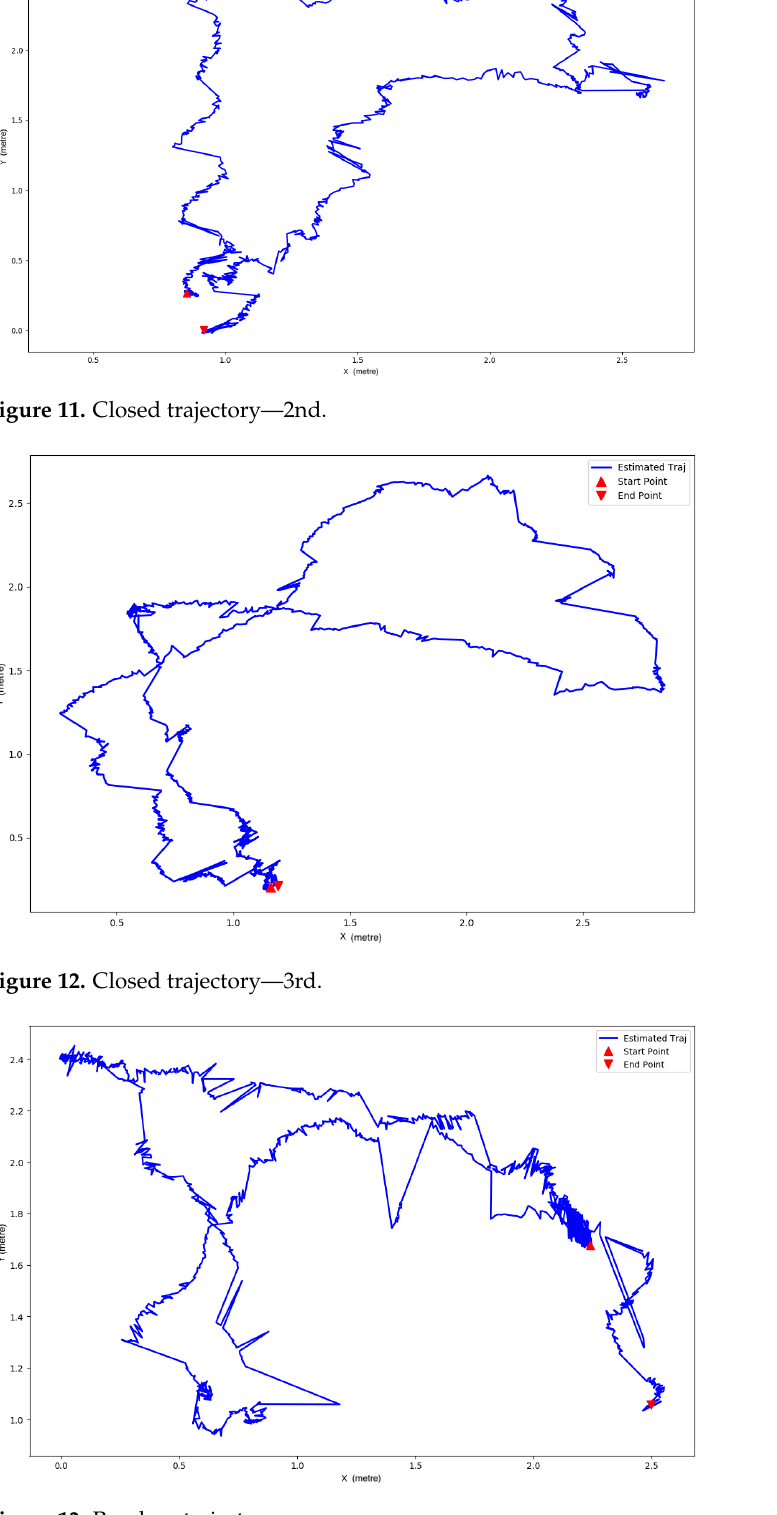
Figure 13. Random